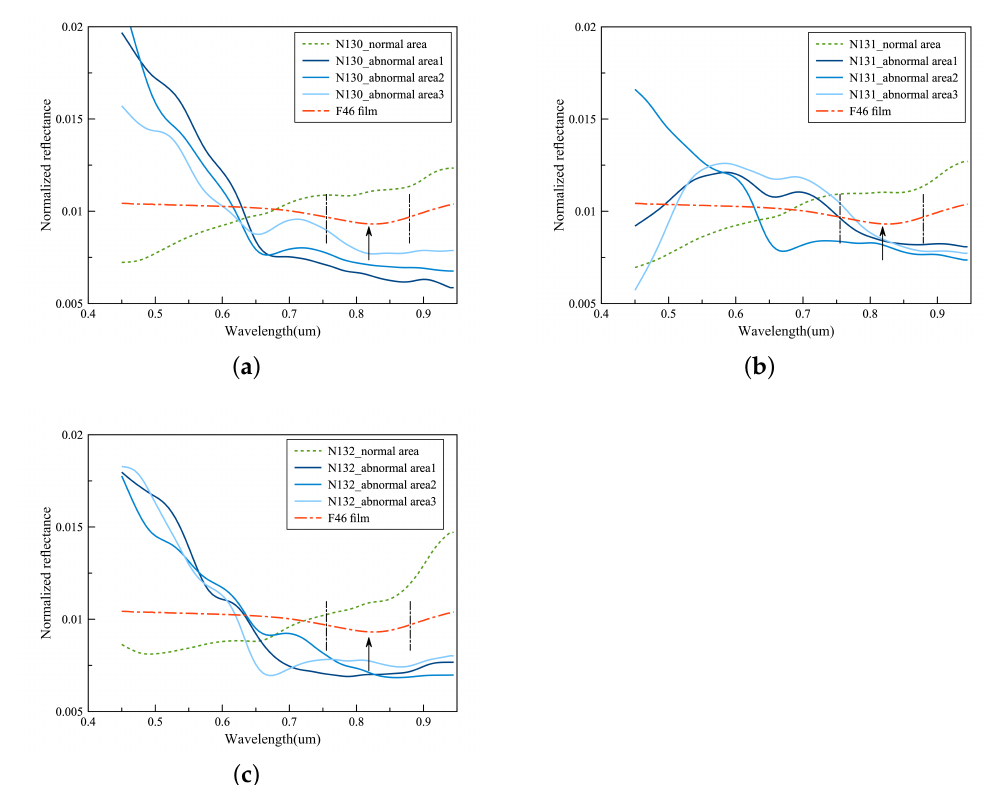
Figure 10. ( a – c ) Comparison of normalized reflectance in the VIS/NIR band of N130, N131, N132, and F46 film. The arrow indicates the wide absorption (750–850 nm) of the F46 film measured in the laboratory. The bright region marked by the red rectangle in Figure 9 is considered to calculate the average reflectance of the abnormal region.